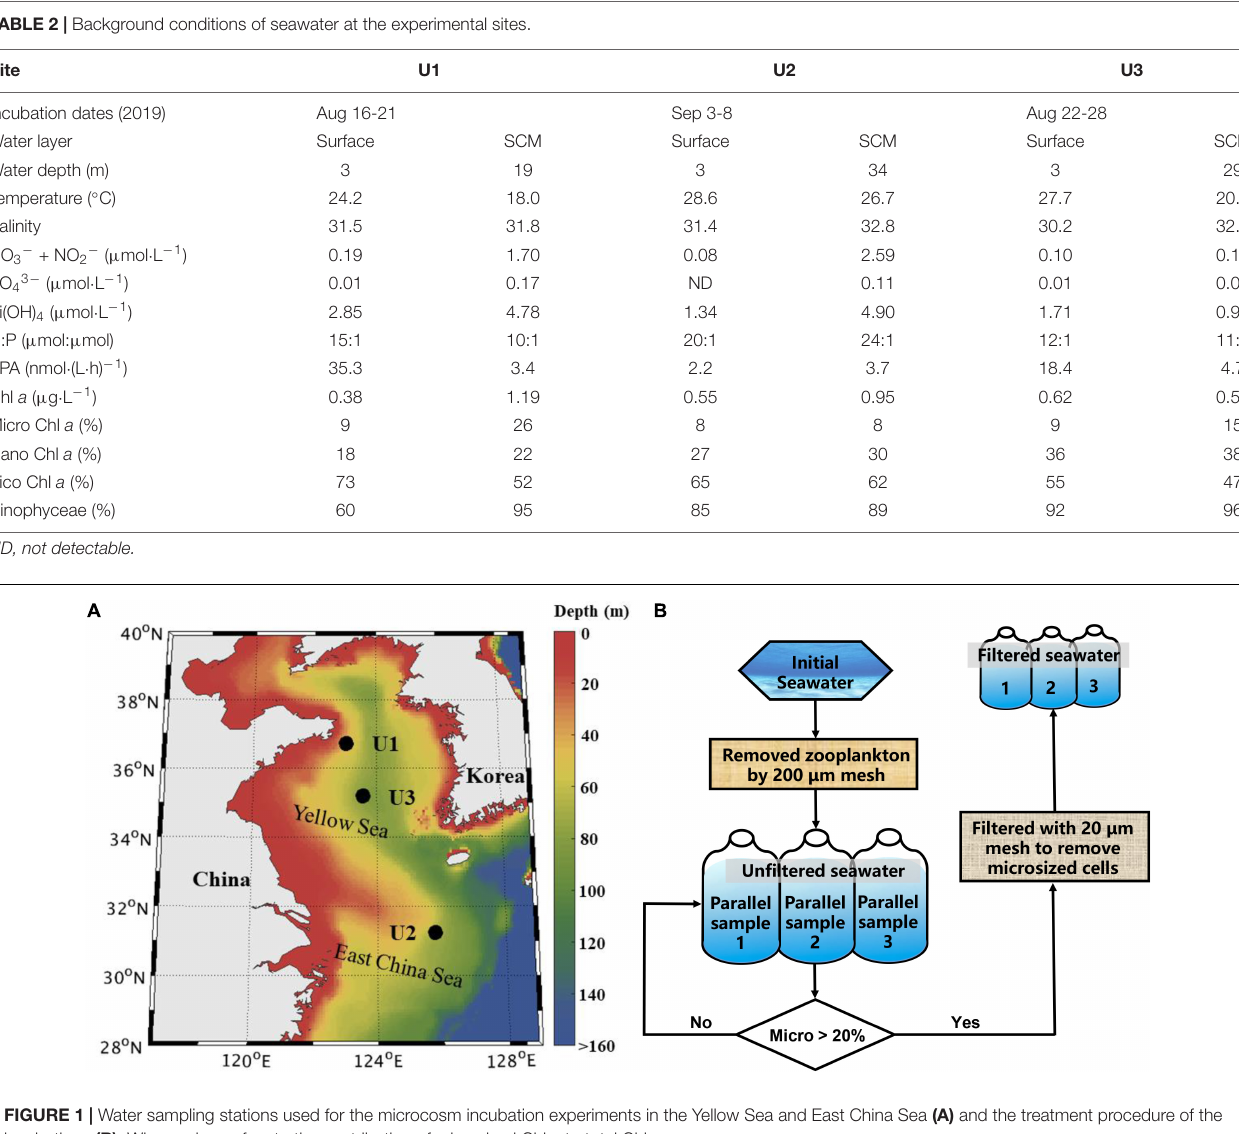
Frontiers in Microbiology |